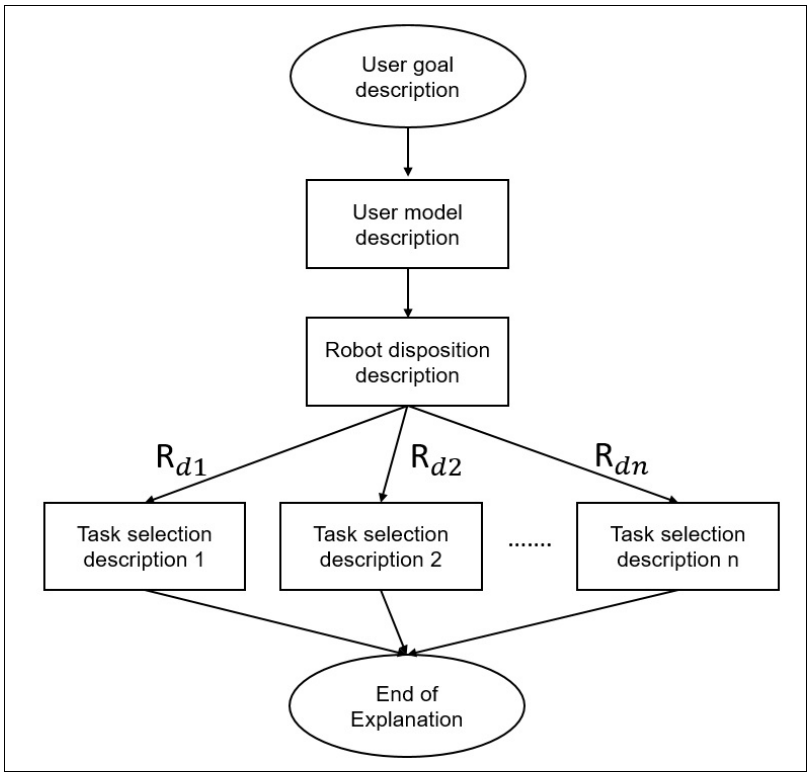
Figure 3. Flowchart exploited by the robot in order to provide an explanation about the reasons that led it to complete the